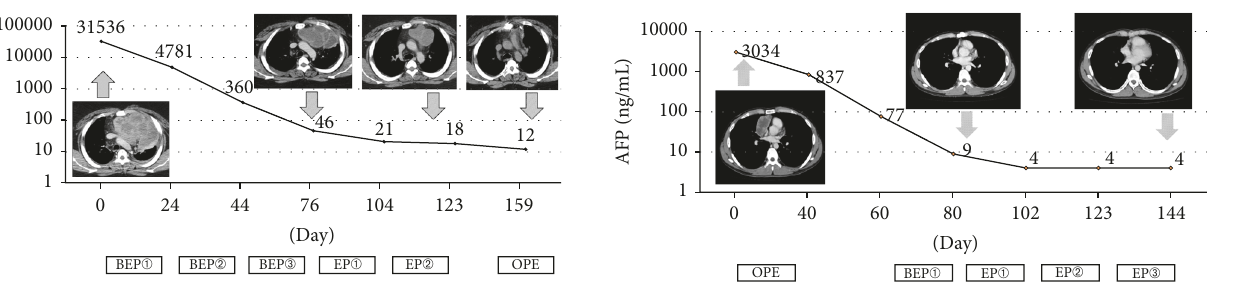
Figure 2: Case 2: a 25-year-old man received initial surgical treatment. AFP: alpha-fetoprotein; BEP: bleomycin, etoposide, and cisplatin; EP: etoposide and cisplatin; OPE: